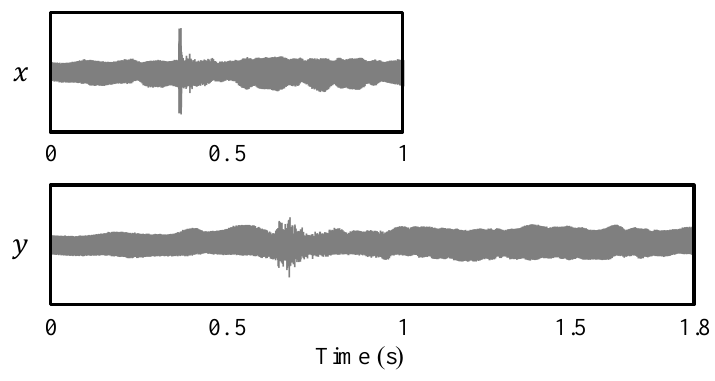
Figure 10. Illustration of a smeared transient as a result of applying PV-TSM. The input signal x has been stretched by a factor of α = 1.8 to yield the output signal y